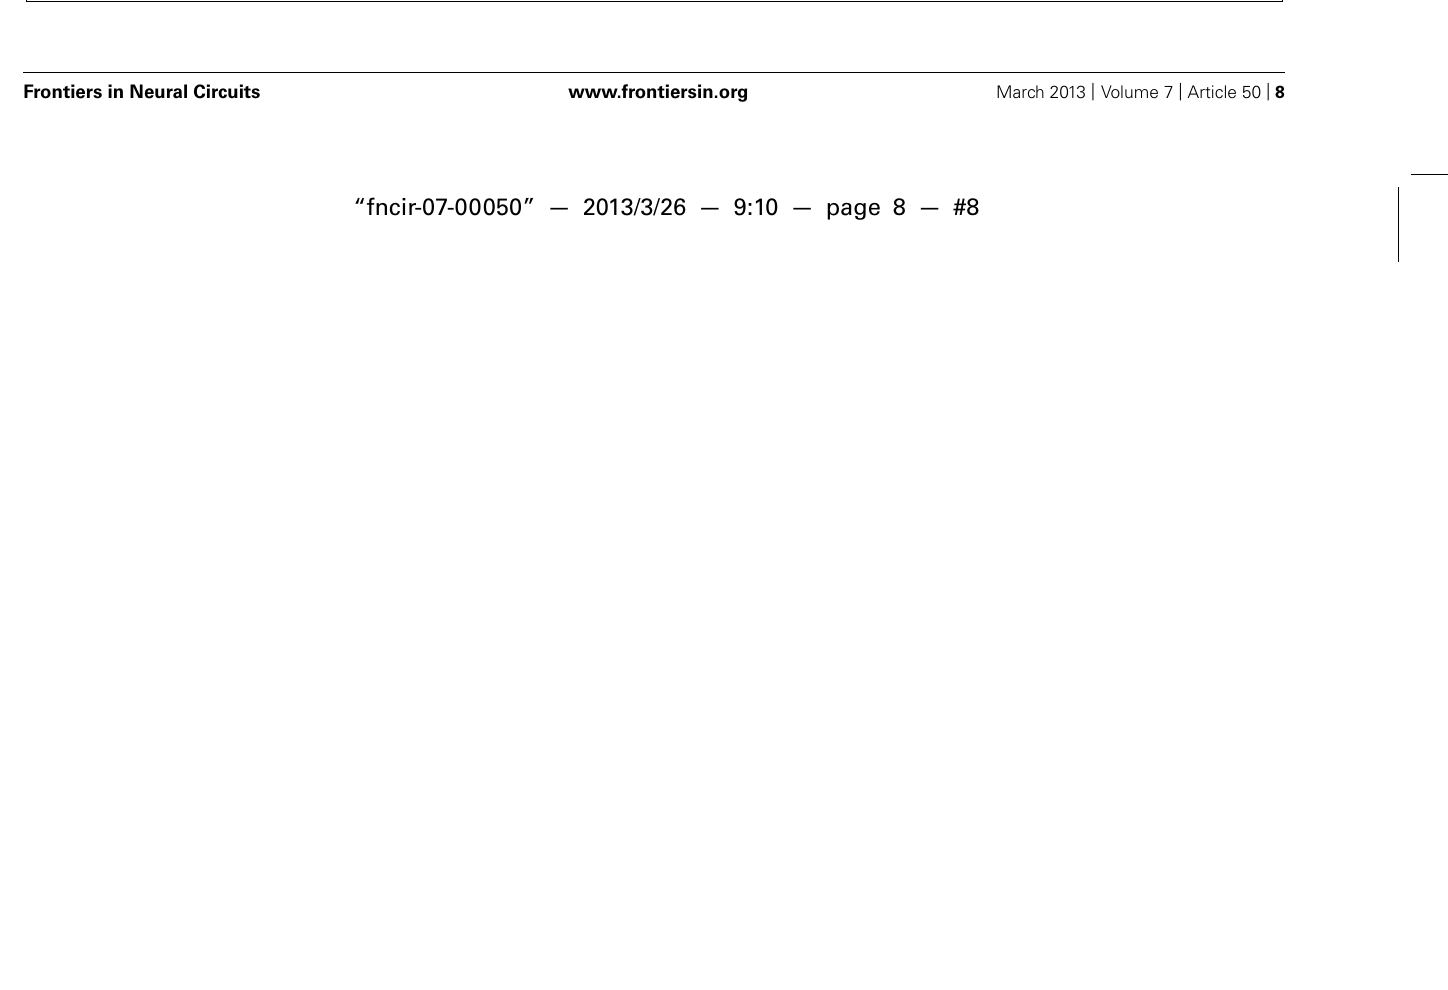
decreases the gradient at the point σ v = 0 deg/s (D) and this decrease is linear.This reduction in gradient of the H1-cell input–output function represents a decrease in sensitivity to changes in the image velocity i.e., a decrease in sensitivity to image acceleration.The results show that increasing σ v directly decreases the sensitivity of the H1-cell to image